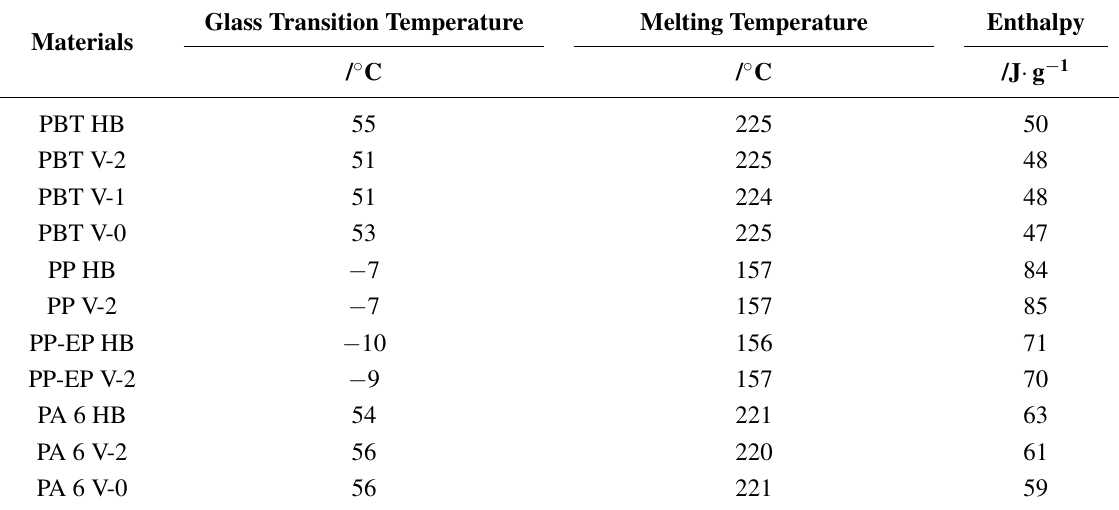
Table 3. Thermal transition